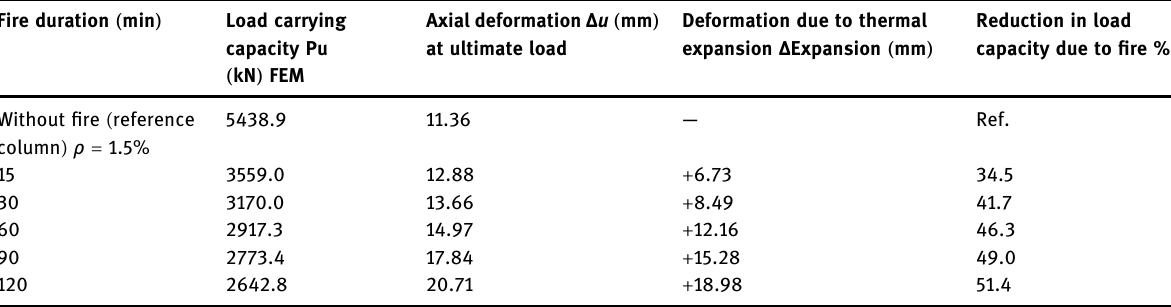
Fire duration ( min )